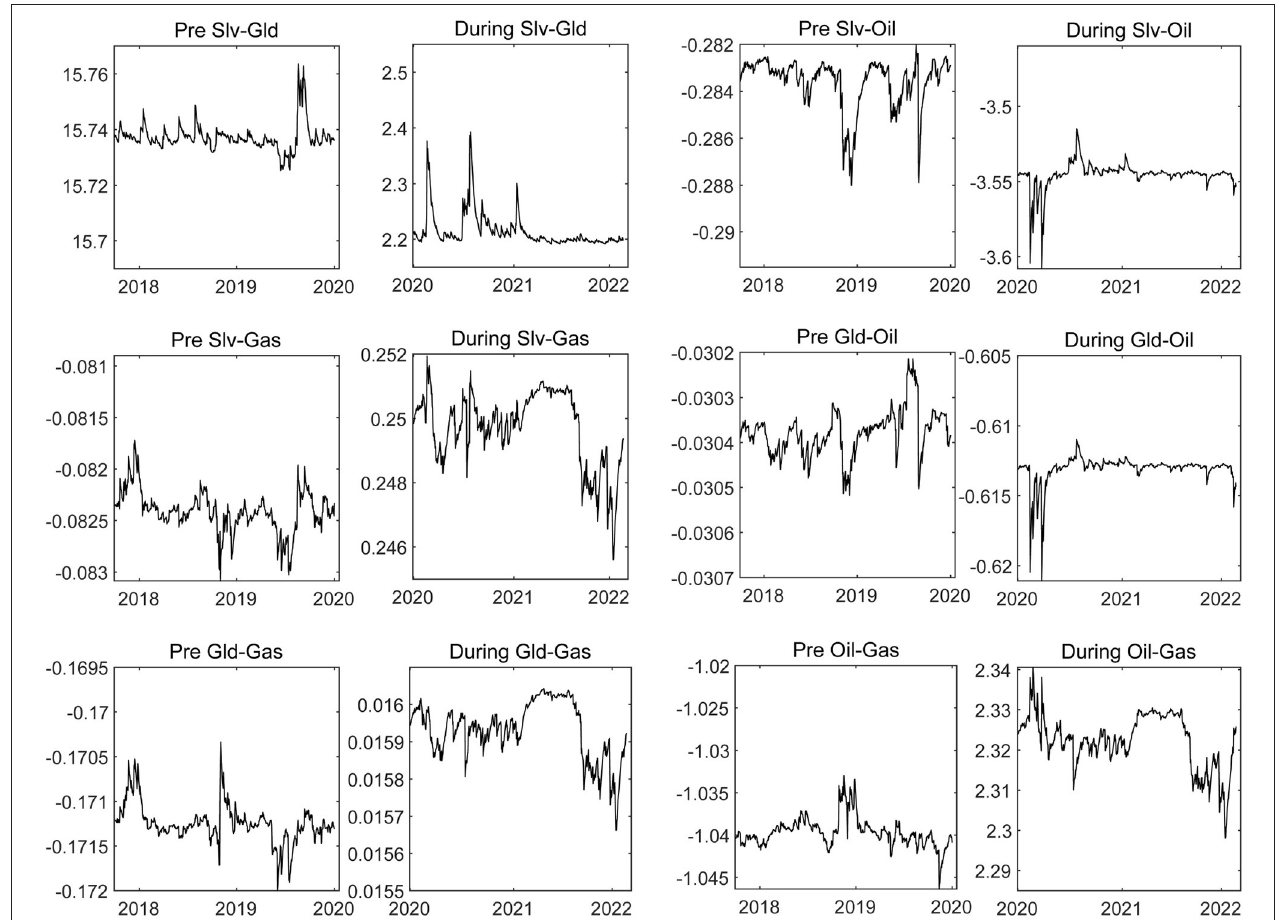
FIGURE 4 | The time-varying net pairwise connectedness of energy and precious metals markets. “Pre” indicates the period before the COVID-19 epidemic, and “During” indicates the COVID-19 epidemic period, and “Slv-Gld” indicates the volatility spillover connectedness between silver market and gold market. If the volatility connectedness index is > 0, the former is the spillover and the latter is receiver of external volatility spillover. If the connectedness index is < 0, the opposite is true. The results of other net pairwise connectedness are interpreted in the same way as